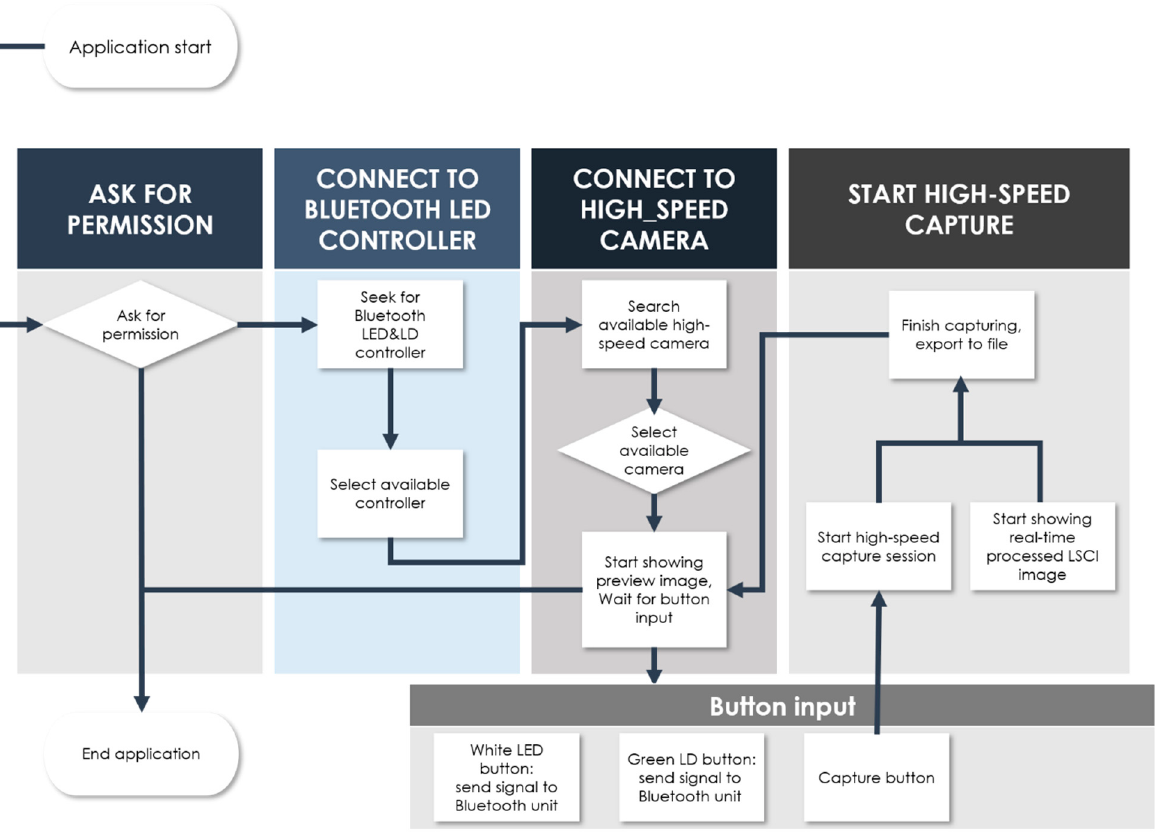
Figure 3. Step procedure diagram illustrating the endoscopy and LSCI operations.